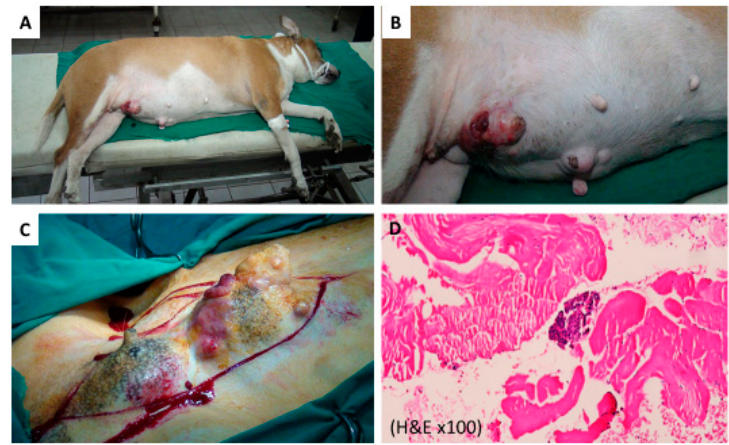
Figure 2. ( A ) Photographic image of control case 1 (Group 1, case 1) treated with surgery. ( B ) A magnified figure of (A) for the tumor area. ( C ) Photo of case during surgery with high amount of bleeding. ( D ) Photomicrograph of tumor tissue, showing ductal carcinoma in situ grade II (H&E